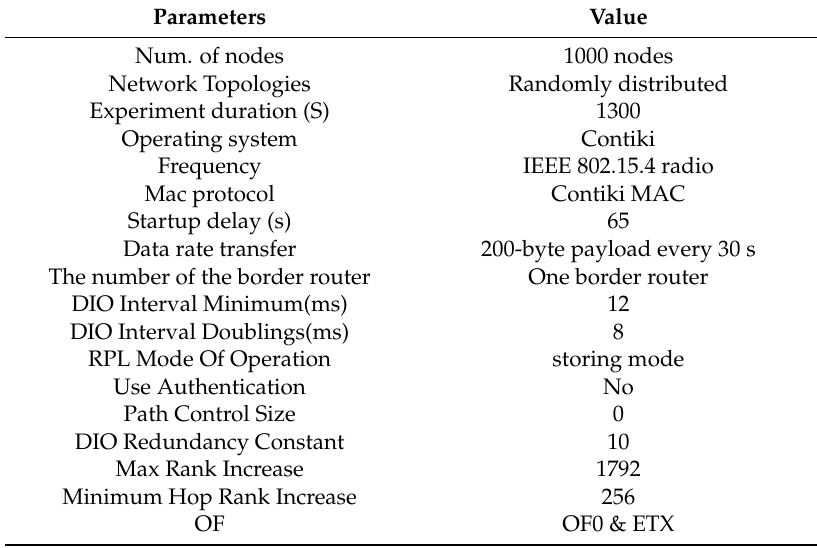
Table 3. Cooja simulator RPL configuration